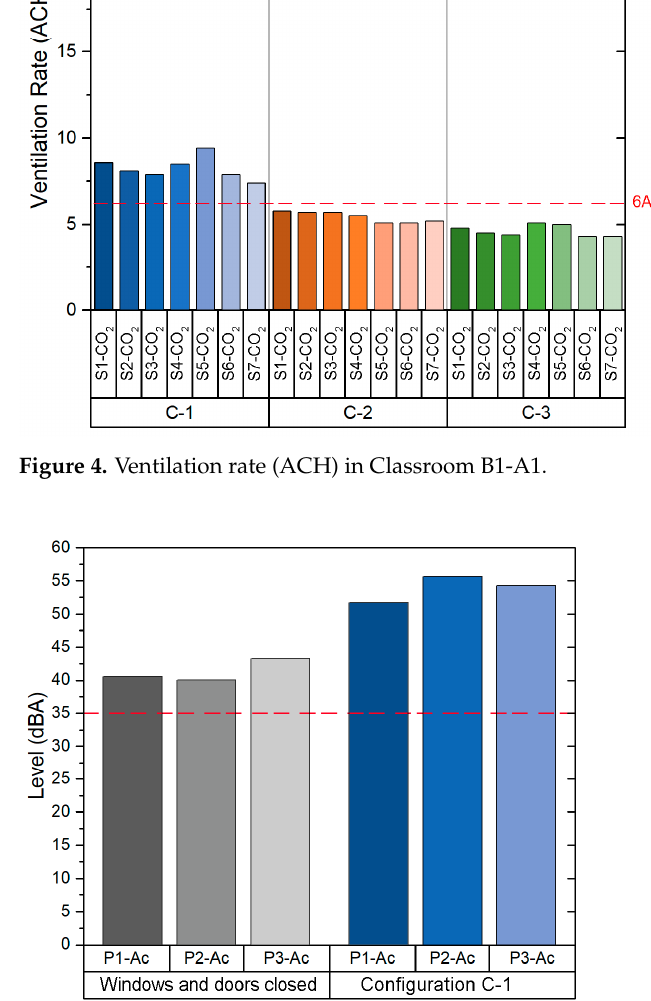
Figure 5. Background noise levels in classroom B1-A1.